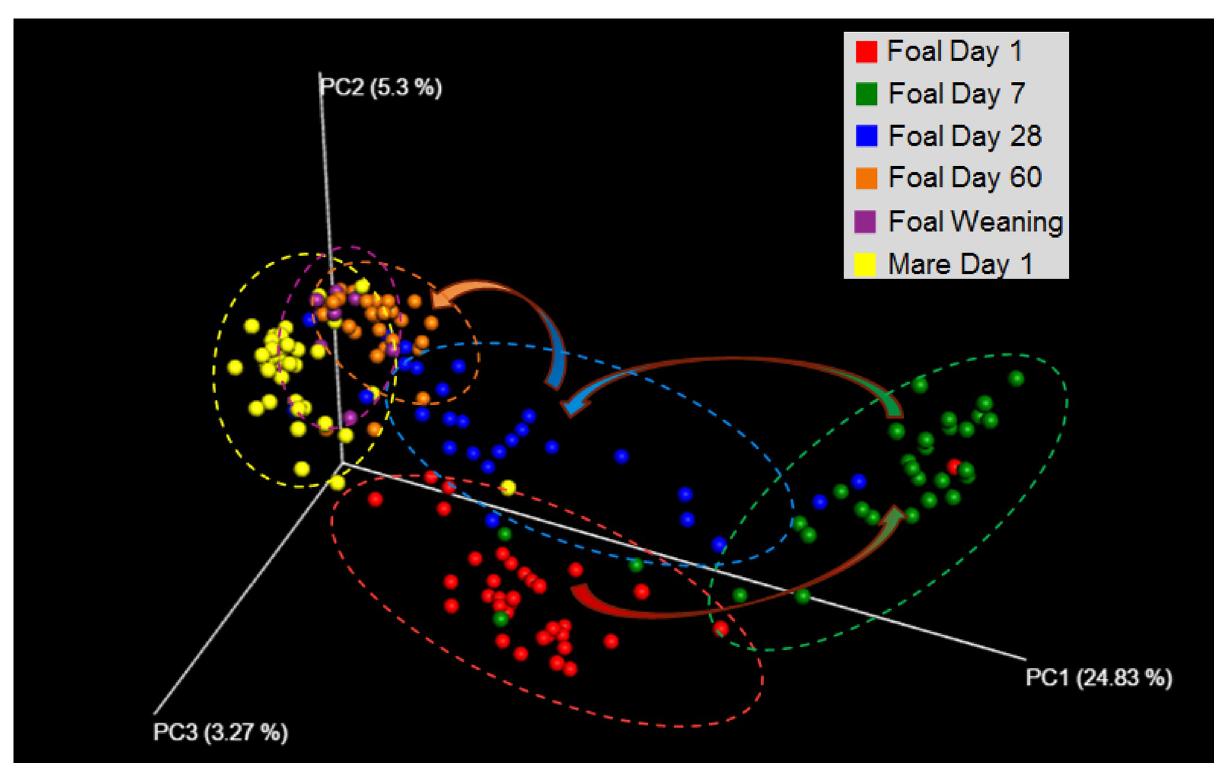
Fig 2. PCA demonstrates how globally foal microbiota changes toward adult microbiota. A principal component analysis of bacterial populations found from sequence data shows that the microbiota transitions toward the adult GI microbiota. Foal samples at Days 1, 7, 28, 60, and weaning, respectively, cluster by day with Day 60 and weaning samples overlapping with the adult mare. Loose clusters represent periods of variability. Segregation of samples by farm can be found in S1 Fig.